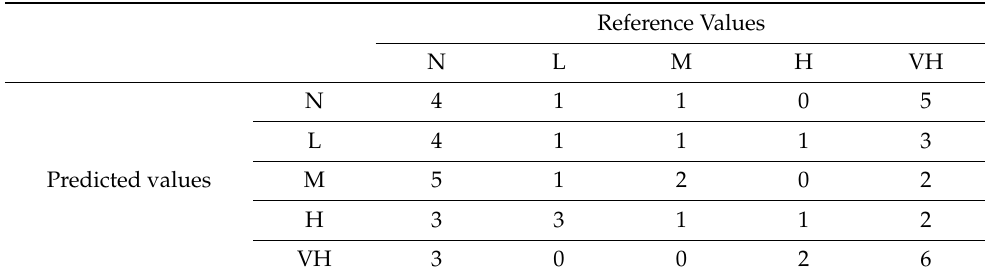
Table 6. Confusion matrix for infestation levels (N, none; L, low; M, moderate, H, high; VH, very